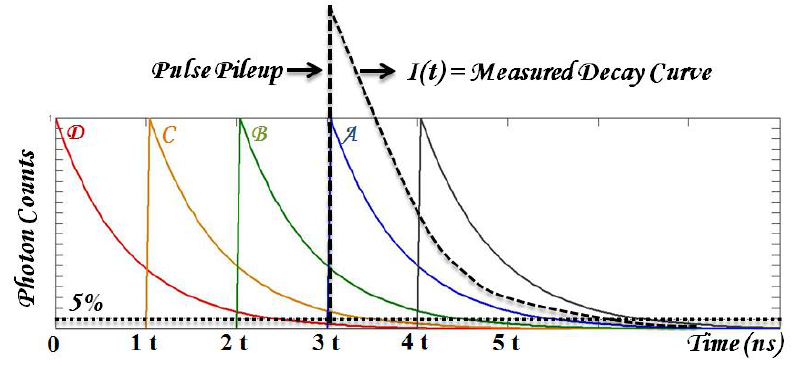
Figure 6. Schematics of incomplete decay when an ultrafast laser is used in time-domain TRF. Ultrafast laser pulses with an inter-pulse interval of t yield fluorescence emission that follows exponential decay profiles, as indicated by the decay curves A–D , corresponding to each pulse. The tails of previous decays ( B–D ) are superimposed on the current decay ( A ) when t is not sufficiently long for a full fluorescence decay, causing distortion of the measured decay curve, I(t). The effect becomes more prominent when t is decreased or with a slow decay profile (adapted from [68], with permission from